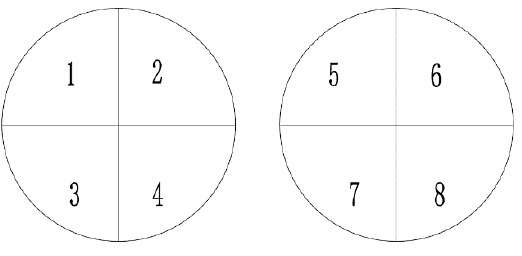
Figure 12. The area distribution map of the powersphere.